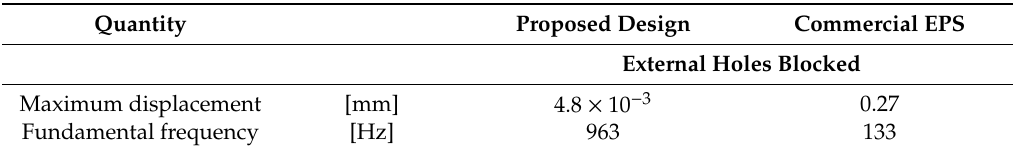
Table 7. Comparison between proposed and commercial